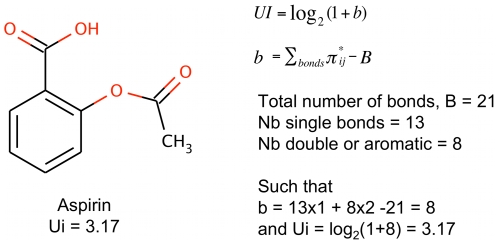
Calculation of UI on Aspirin.UiAspirin = 3.17: aspirin has a total of 21 bonds, such that B = 21, 13 single bonds that have a contribution of 1 to b, and 8 double and aromatic bonds that have a contribution of 2 to b, such that the multiple bond count b is equal to b = 13x1+8x2 - 21 = 8. Thus Ui = log2(1+b) = log2(1+8) = 3.17.